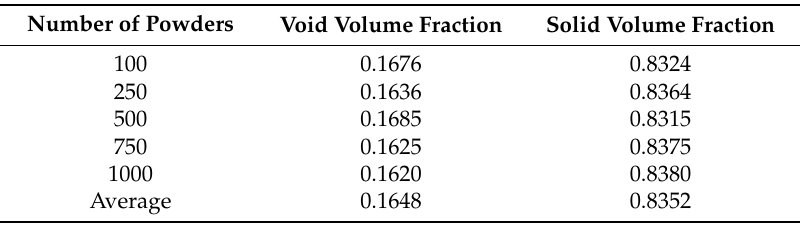
Table 2. Volume fractions of void and solid of packed powder bed with the various number of powders.